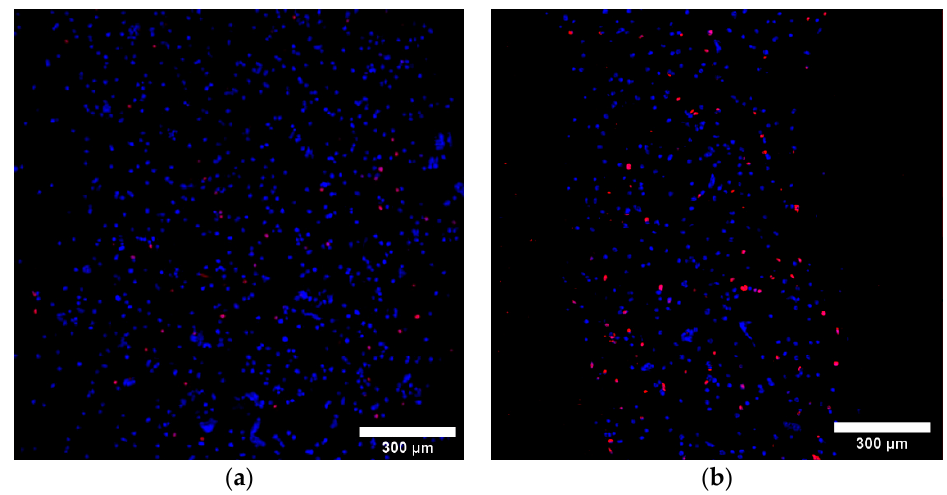
Figure 7. Live/dead fluorescence images (10 × magnification) of ( a ) 3/4 Alg/Gel and ( b ) 3/7 Alg/Gel bioinks measured immediately after extrusion. Blue color represents all cells, alive and dead, stained with Hoechst 33342, and red color represents propidium-iodide-stained dead cells. The scale in both figures is 300 µ m. The resultant cell viability values for the 3/4 and 3/7 Alg/Gel constructs are 85.2 ± 9.1% and 64.2 ± 10.6%, respectively (Table 1). The random forest classification, logistic regression, and support vector regression models predicted acceptable cell viability for both material conditions based on tested material concentration and printing parameters (Table S1). All predictions were made keeping extrusion pressure constant at 95.4 kPa. Table 1. Predicted cell viability values are compared against experimental values for corresponding material concentrations of alginate and gelatin. Actual values represent the mean ± standard deviation for all samples ( n = number of samples) measured from at least three batches of Alg/Gel bioink.